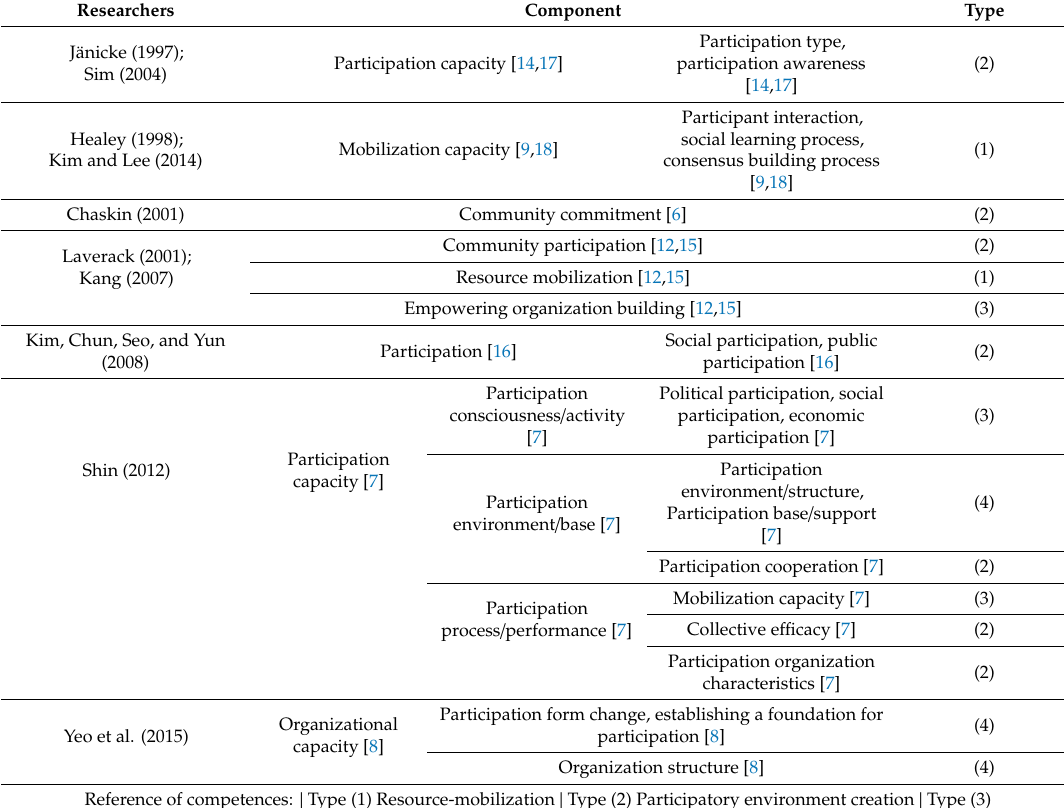
Table 1. The components of community competence 3. Rural Community Support Project